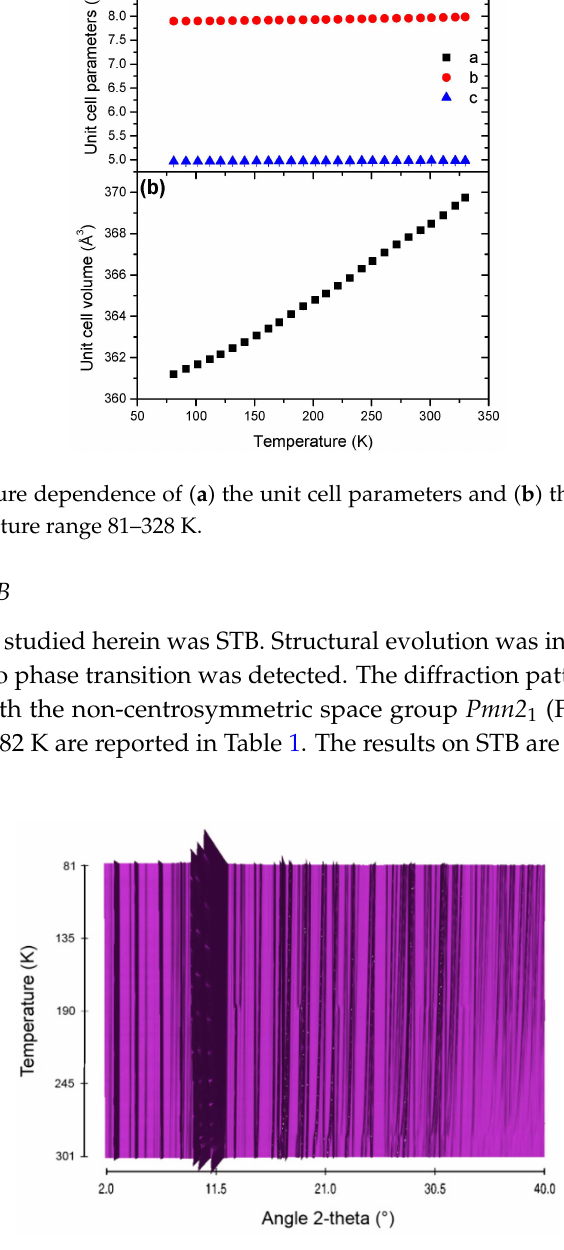
Figure 11. Sequential plot of the diffraction patterns of STB within the range of temperature 81–301 K. The evolutions of the unit cell parameters and of the unit cell volume are shown in Figure